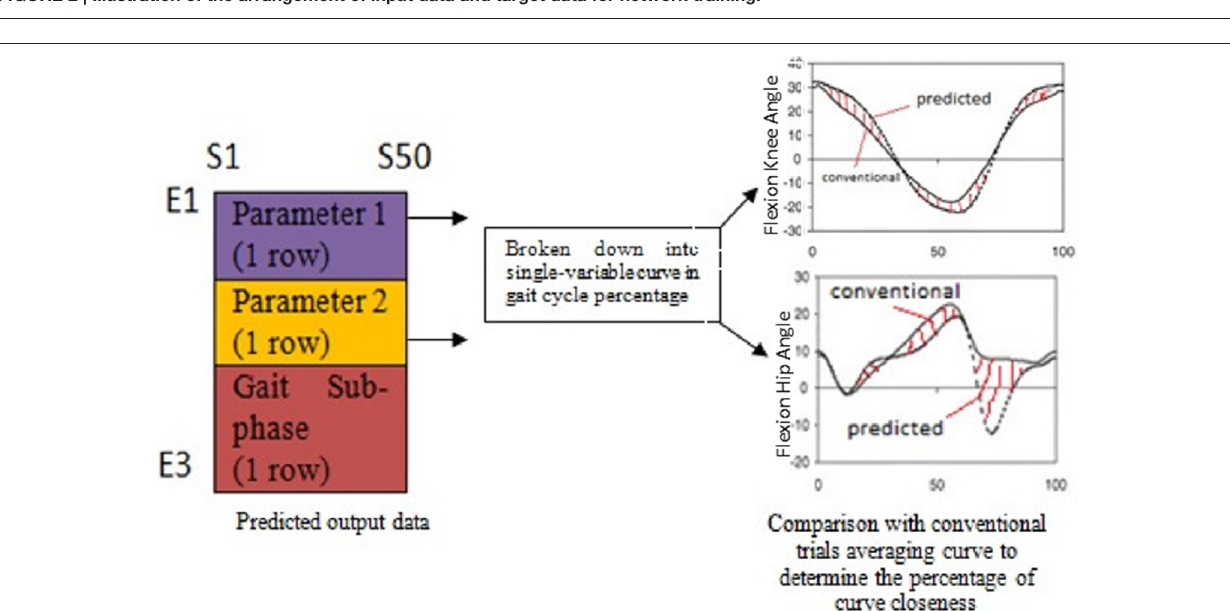
FIGURE 2 | Illustration of the arrangement of input data and target data for network training.